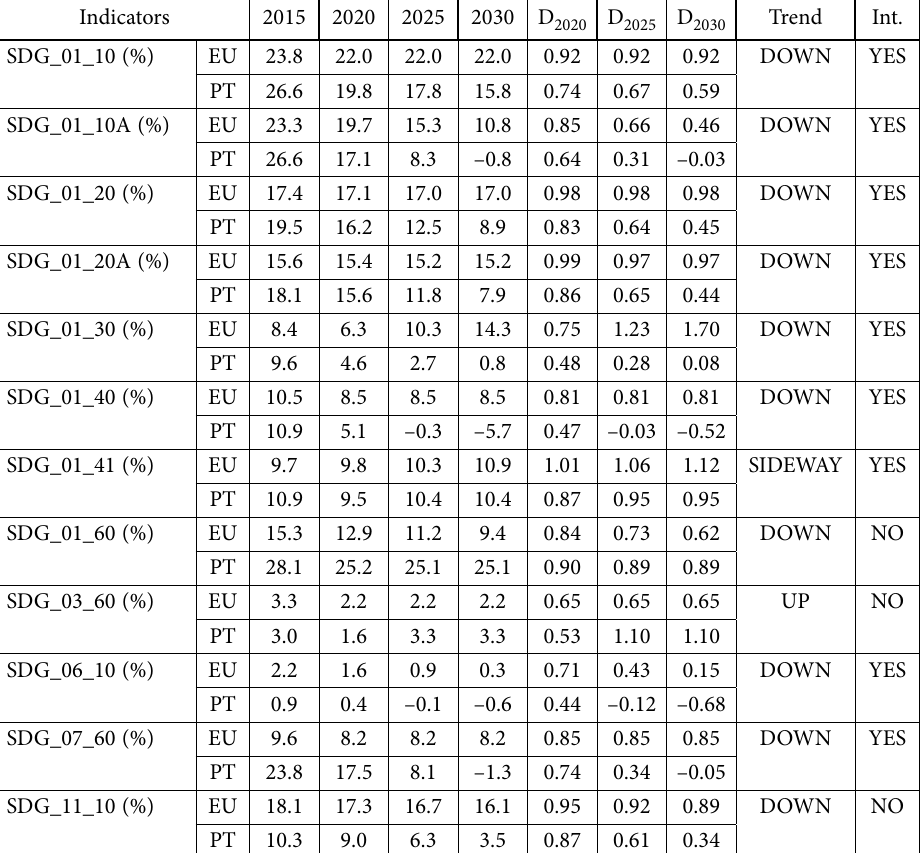
Table 2. SDG 1 – No